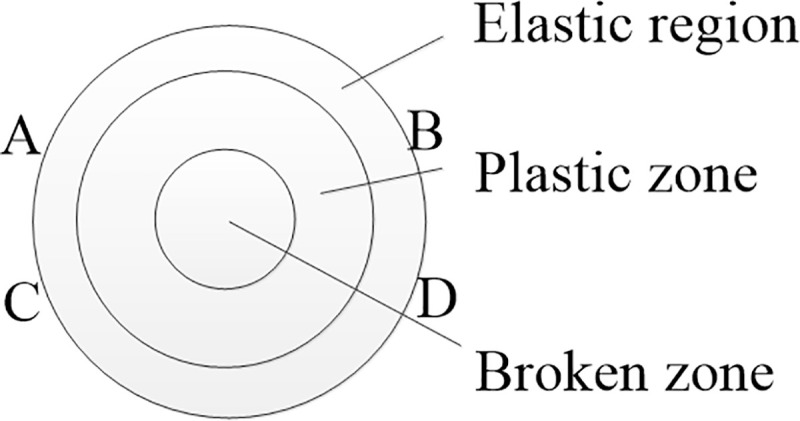
Distribution of stress state of rock.